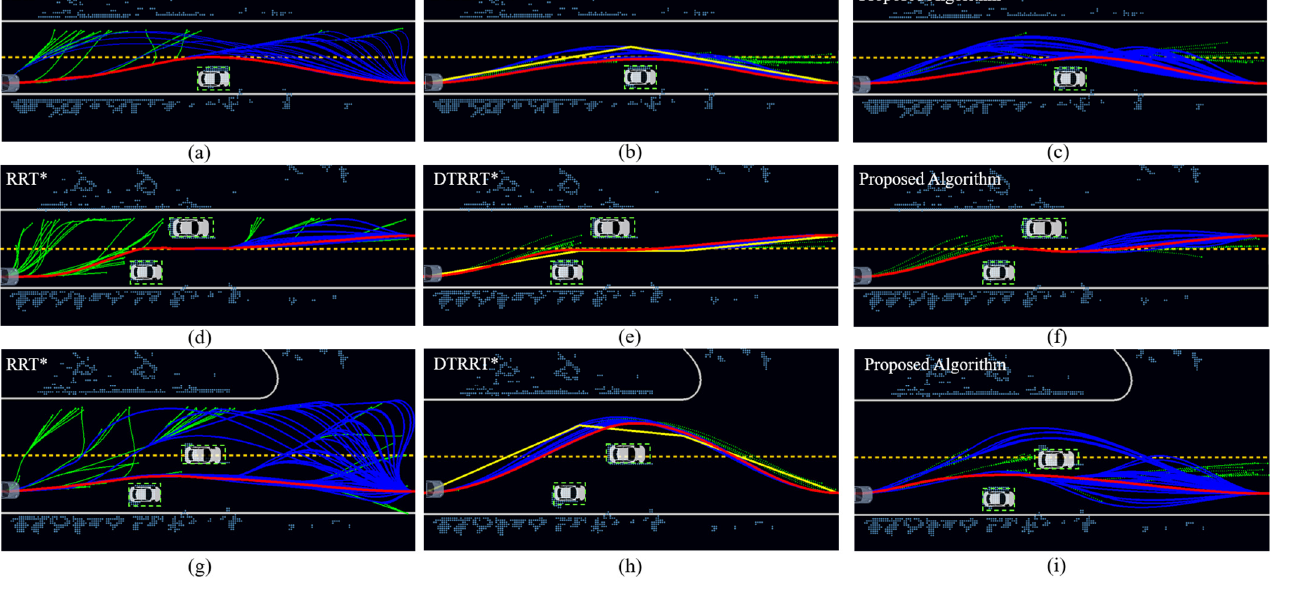
Table 8. The sampling efficiency analysis results of the three methods.